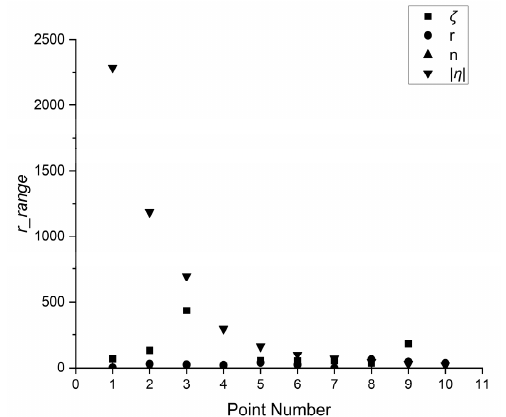
Figure 12. Non-linearly related random variables: ( a ) the mold of the shape coefficient’s; ( b ) the vertex random distribution factor.